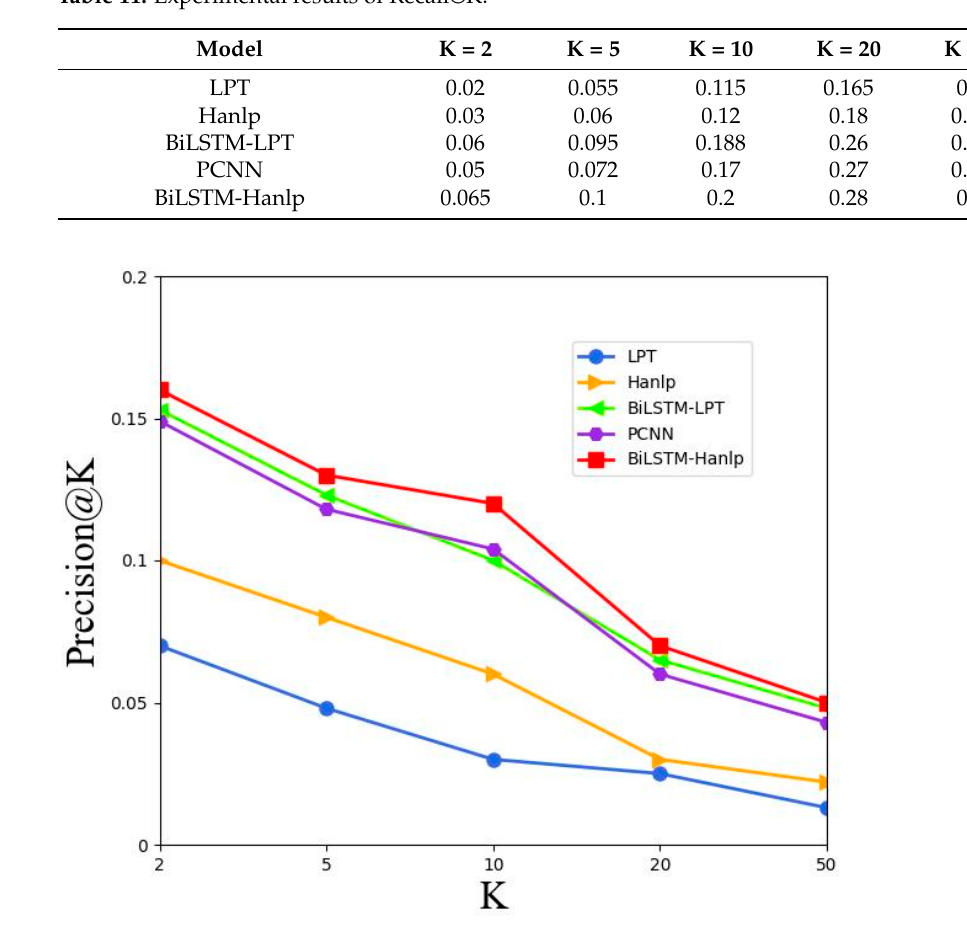
Table 11. Experimental results of Recall@K.